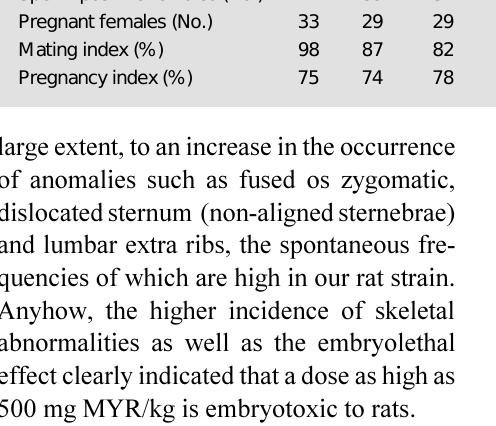
Table 3 - Effects of ß-myrcene (0, 100, 300 and 500 mg/kg) administered by gavage during the premating, mating and gestation periods on parameters evaluated at the time of cesarean section performed on pregnancy day 21 for fetal body